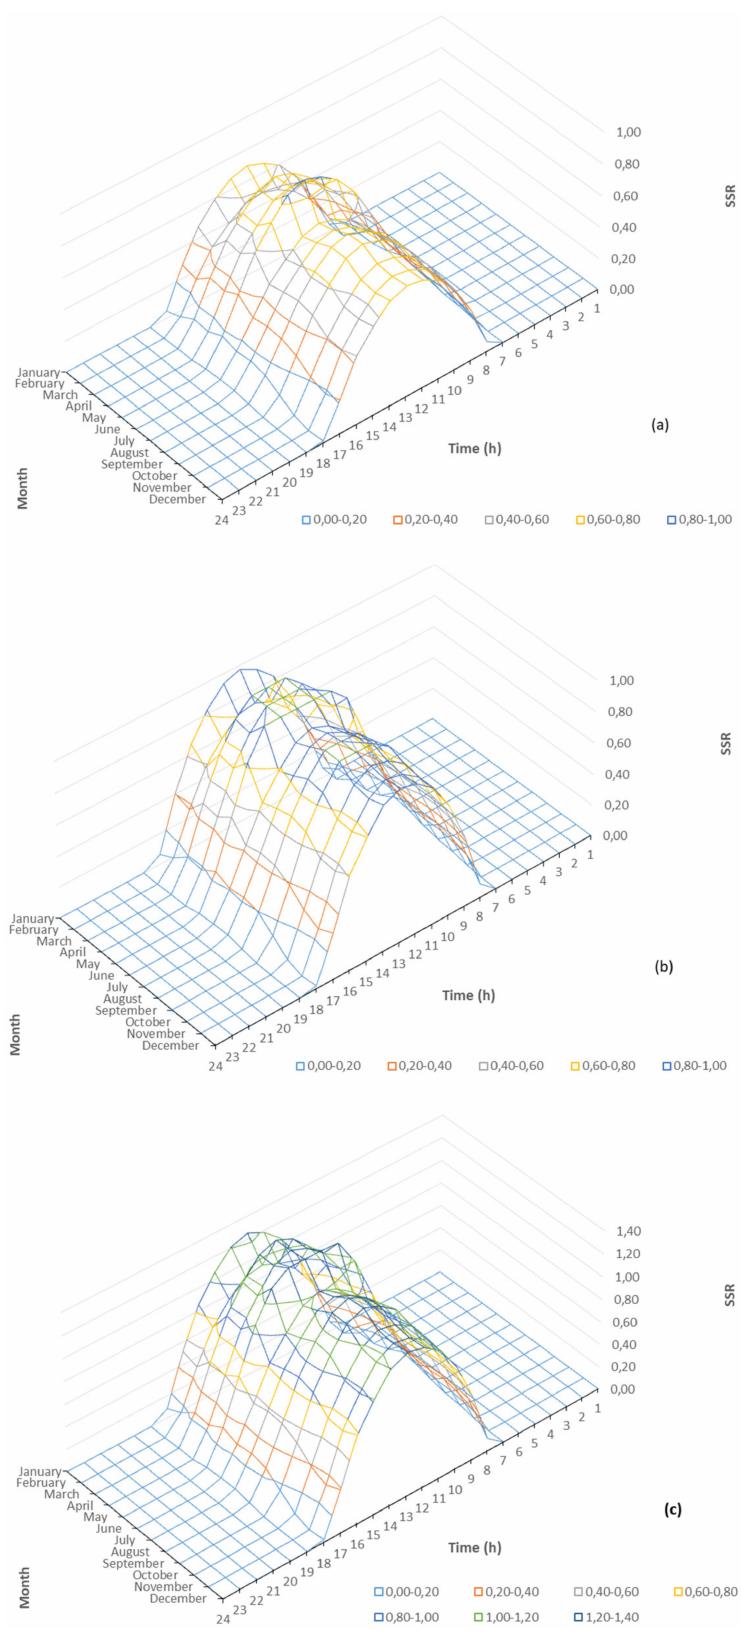
Figure 13. The ratio of PV systems meeting the hourly electricity need of the hospital ( a ) 25 MW of PV capacity, ( b ) 35 MW of PV capacity, ( c ) 45 MW of PV